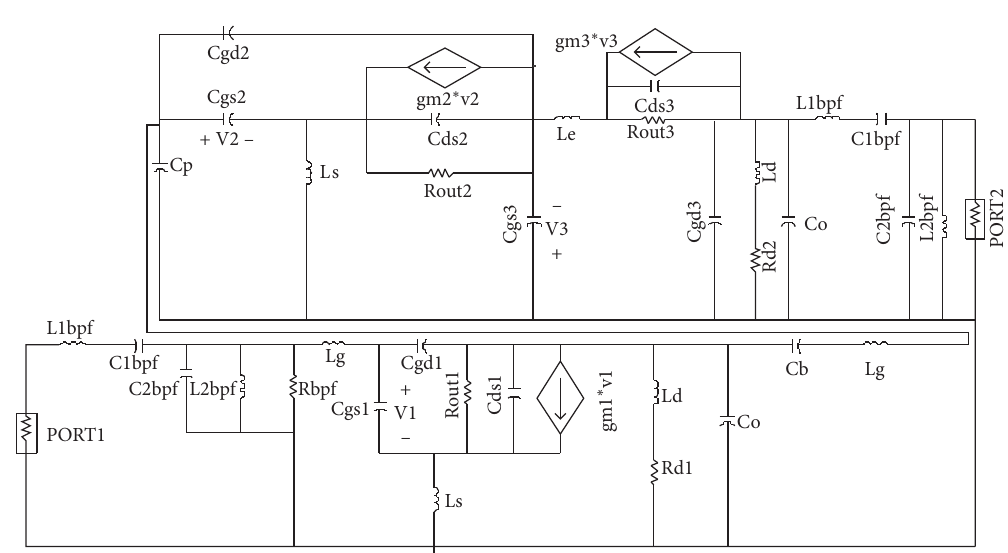
Figure 3: The equivalent circuit of Figure